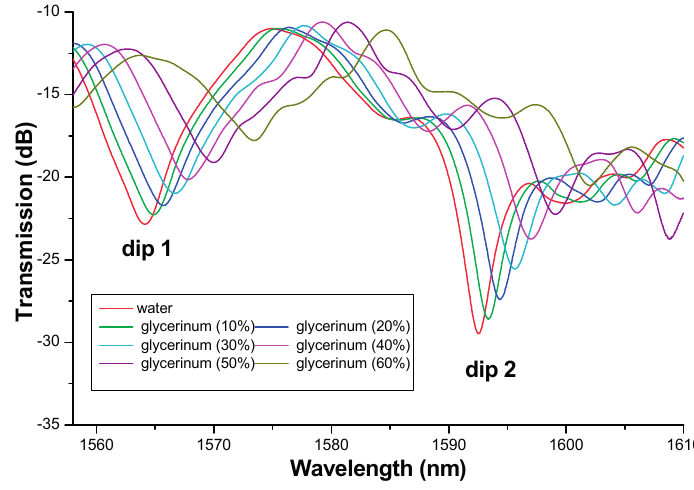
Figure 3. Transmission spectra of the proposed sensing structure surrounded with glycerinum liquids of different concentrations.